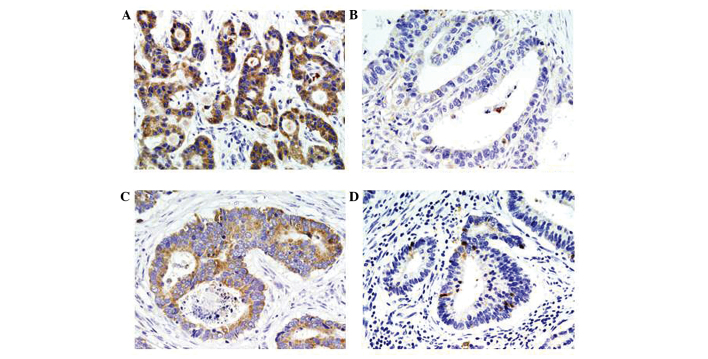
Immunhistochemical staining of Smac/DIABLO in gastrointestinal carcinomas. Smac/DIABLO immunoreactivity was predominantly observed in the cytoplasm. (A) High expression of Smac/DIABLO in gastric carcinoma. (B) Low expression of Smac/DIABLO in gastric carcinoma. (C) High expression of Smac/DIABLO in rectal carcinoma. (D) Low expression of Smac/DIABLO in rectal carcinoma. Smac/DIABLO, second mitochondria-derived activator of caspases/direct inhibitor of apoptosis-binding protein with low pI. (A–D, magnification, ×200).